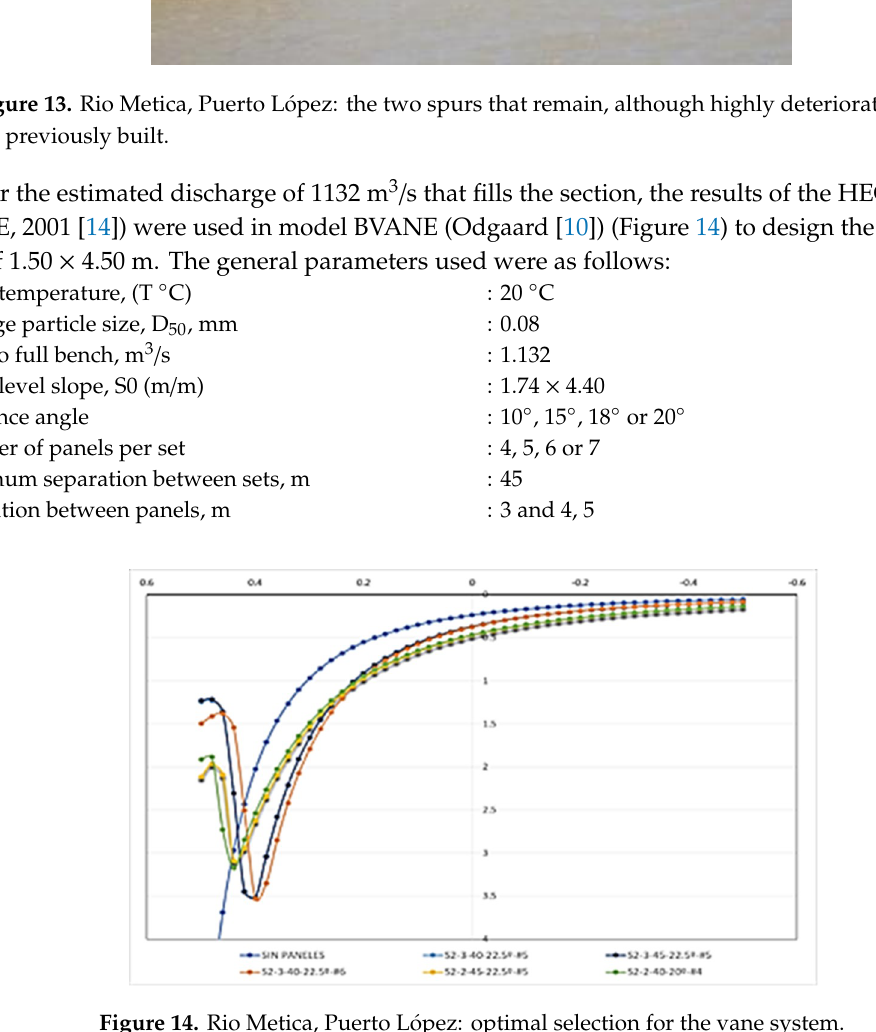
Table 2. Redesign of the submerged vane system for the Metica River in Puerto López, Department of Meta (Hidroconsulta [12]).